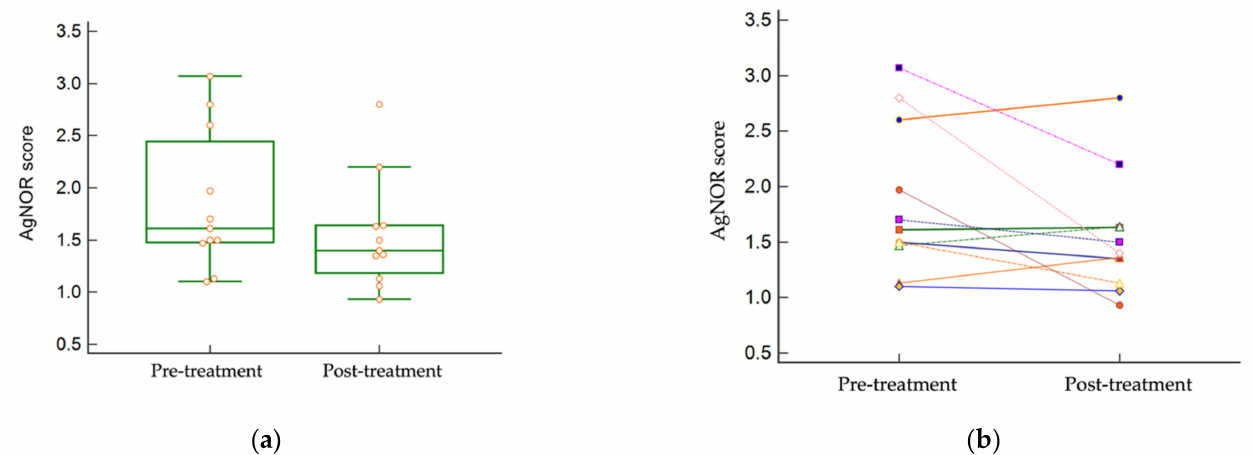
Figure 4. AgNOR scores in paired tumor samples. There was no statistically significant difference between pre- and post-treatment AgNOR scores ( p = 0.0885). ( a ) The median AgNOR score pre- and post-treatment. ( b ) Individual tumor paired AgNOR scores. Three patients had a decrease >1 in the AgNOR score following treatment.